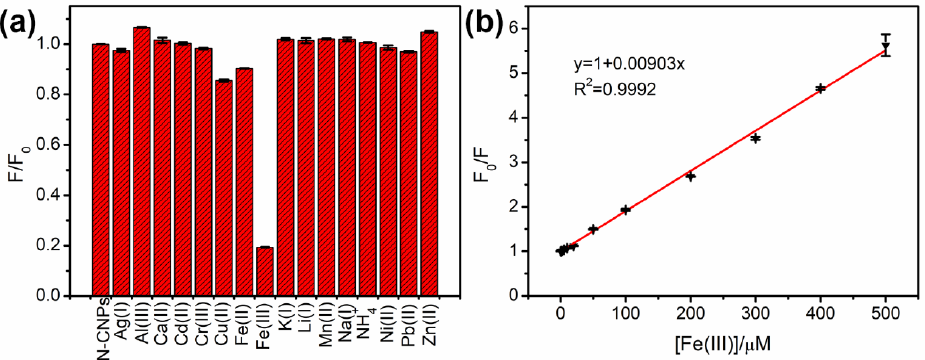
Figure 5. ( a ) Selectivity of N-CNPs with different ions at the same concentration (500 μM). ( b ) The linear relationship between F 0 /F and Fe(III) concentration. F and F 0 were the PL intensities (424 nm) of N-CNPs at 340 nm excitation in the presence and absence of ions, respectively.